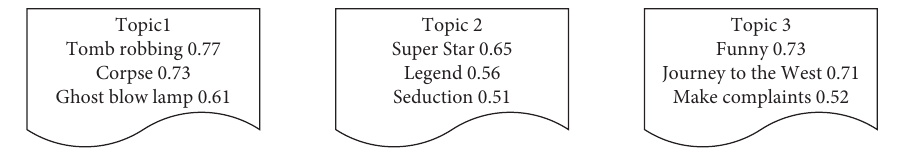
Figure 5: The topic of short video.